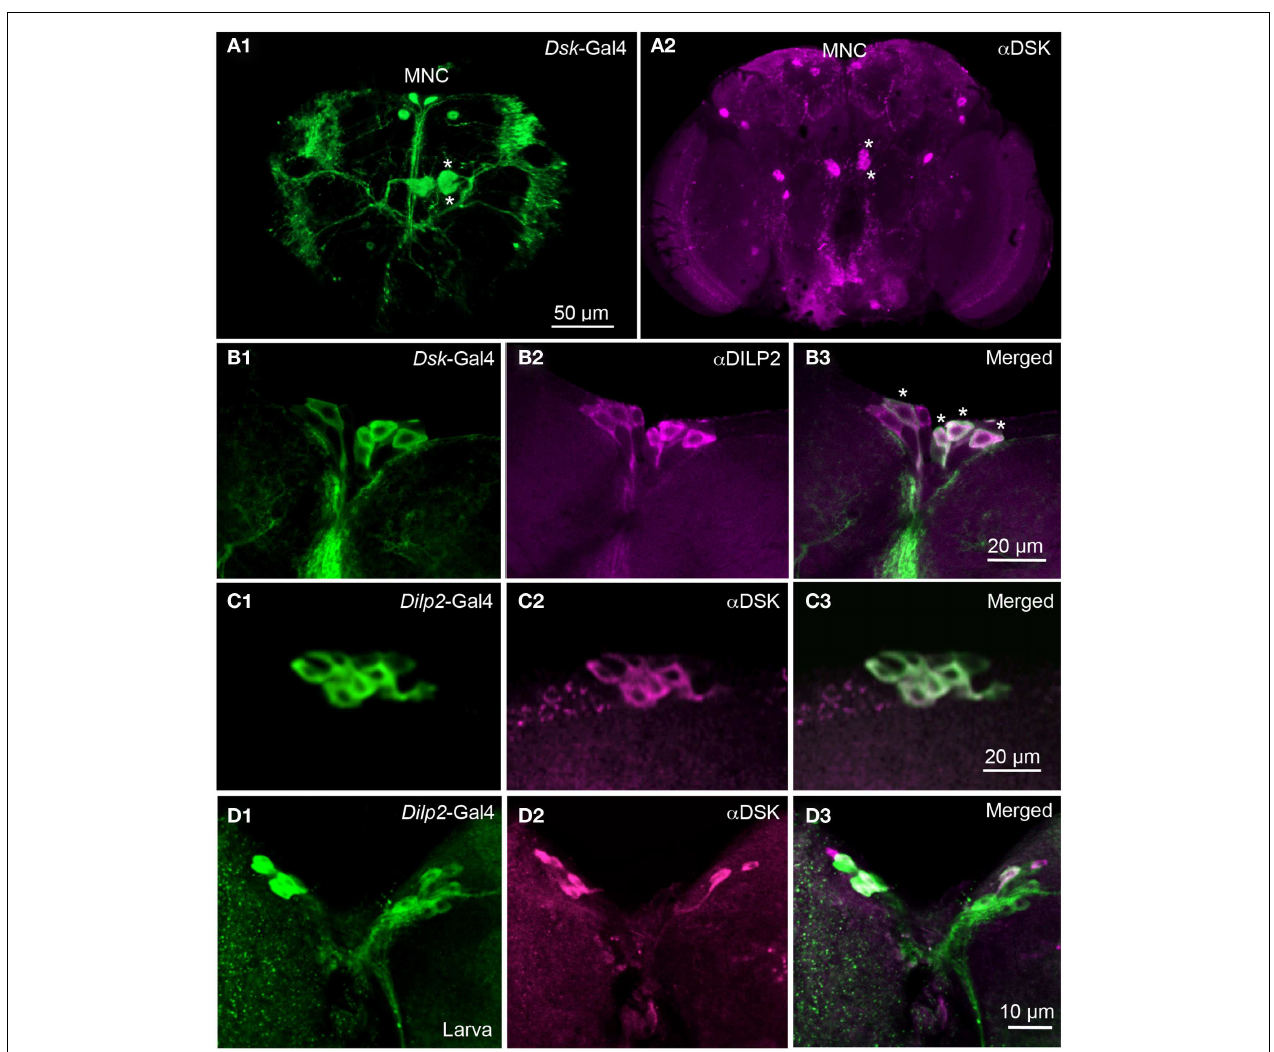
descending to the ventral nerve cord (B1–B3) .The adult IPCs co-localize Dsk -Gal4 expression (green) and DILP2 immunoreactivity (magenta). Cells with co-localized markers are indicated by asterisks (C1–C3) . Co-localization of Dilp2 -Gal4-driven GFP and DSK-immunolabel in IPCs of the adult fly.The majority of the GFP expressing IPCs also display DSK immunoreactivity (D1–D3) . In the larval brain the IPCs are double-labeled with antiserum to DSK and Dilp2 -Gal4-driven GFP.The markers co-localize in the majority of the IPCs, but with stronger DSK labeling in some cells. In these images the intensity of mCD8-GFP fluorescence was improved by using antiserum to GFP or